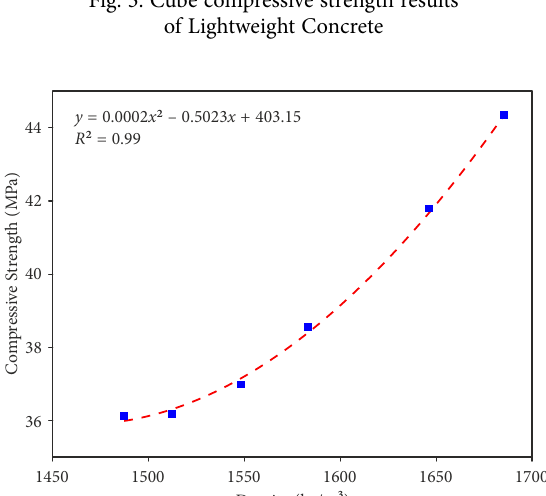
MixesM1 Lightweight Concrete Fig. 3. Cube compressive strength results of Lightweight Concrete